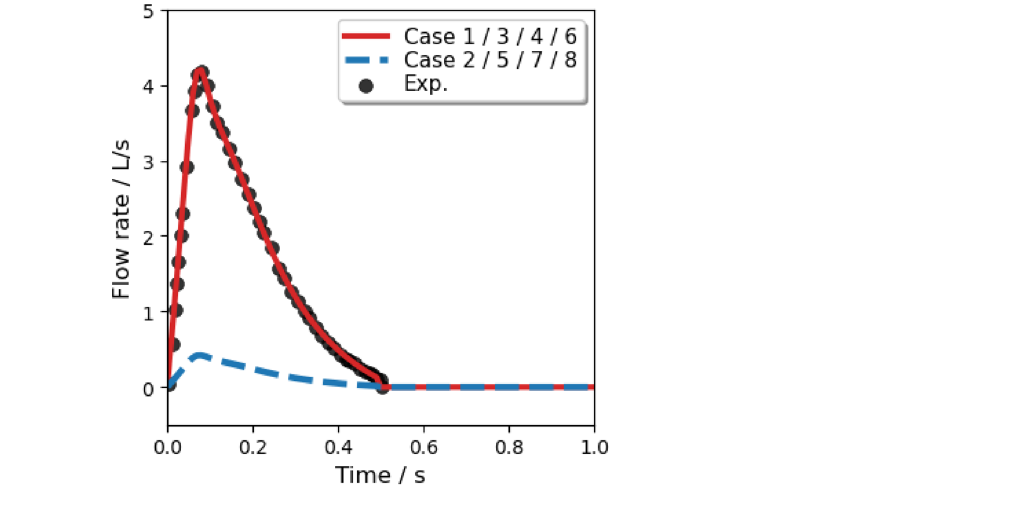
Figure 11. Mass flow rate of a single